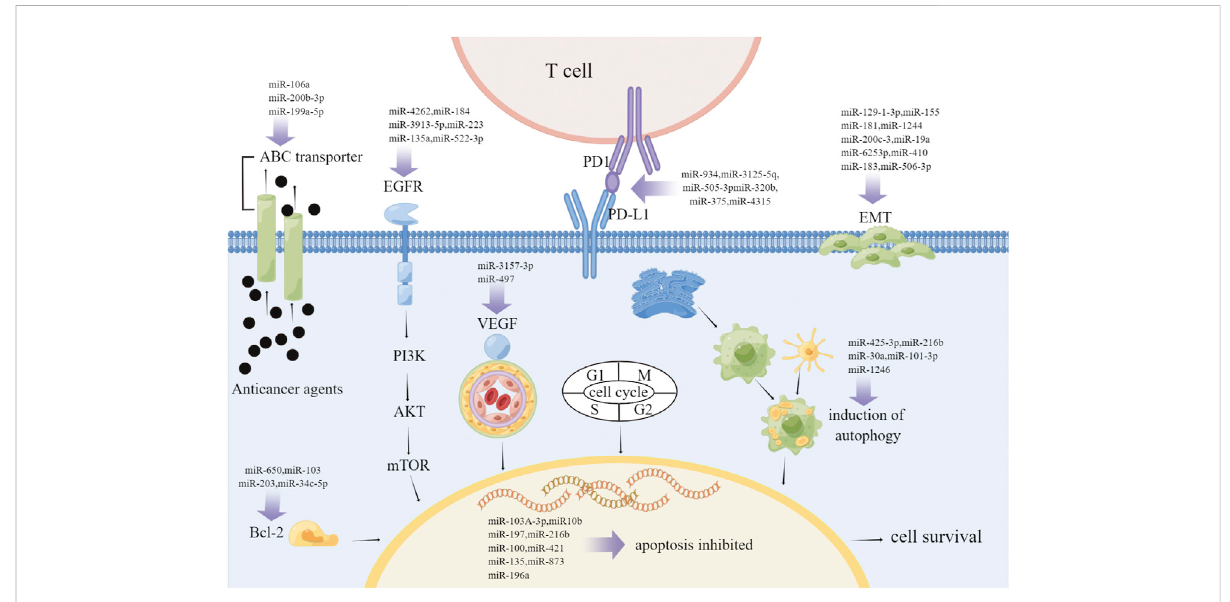
FIGURE 2 Drug resistance in non-small cell lung cancer. The mechanisms of drug resistance in NSCLC are complex and diverse, including ABC transporter activity, anti-apoptosis, autophagy induction, EGFR mutation, EMT promotion, angiogenesis promotion and checkpoint changes. The fi gure shows the mechanism of miRNA involved in different drug resistance processes of NSCLC. Abbreviations: ABC, ATP-binding cassette; EMT, epithelial – mesenchymal transition; EGFR, epidermal growth factor receptor; VEGF, vascular endothelial growth